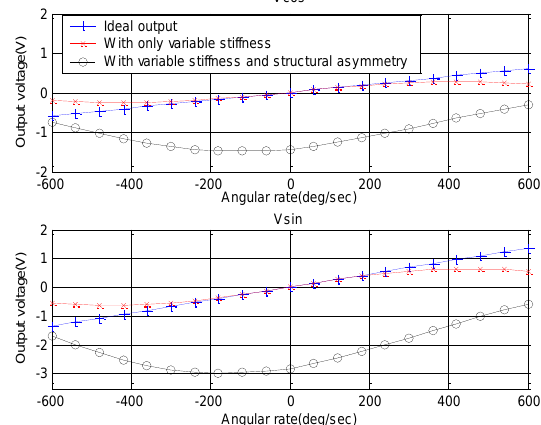
Figure 9. Simulation results of two orthogonal components of the output vector versus angular rates in three circumstances: ideal state, with variable stiffness, with variable stiffness and structural